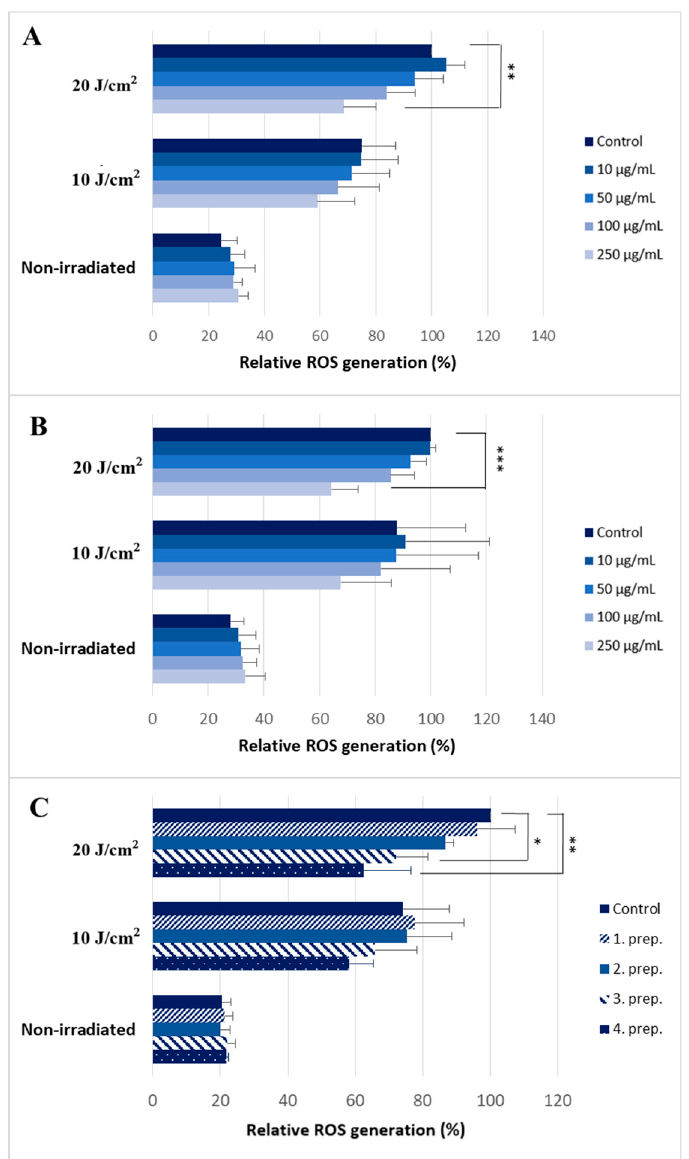
Figure 3. Antioxidant effect of silymarin after UVA-irradiation. Cellular ROS levels after UVA exposure following pretreatment with ( A ) silymarin mixture (Sigma) ( B ) a commercially available silymarin compound (Silegon, Teva), and ( C ) 250 µg/mL silymarin dissolved in four different penetration-enhancers. The bars represent the mean of three independent experiments. Error bars depict SD; *, ** and *** indicate statistically significant difference at p < 0.05, p < 0.01 and p < 0.001, respectively.